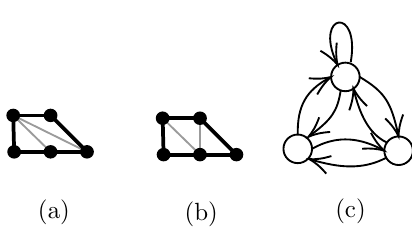
Figure 6 . The toric diagram with two different triangulations is shown in (a), (b). They give the same quiver as in (c). In the crystals, (a) has the initial atom corresponding to the node with an adjoint while (b) has the initial atom corresponding to one of the nodes without